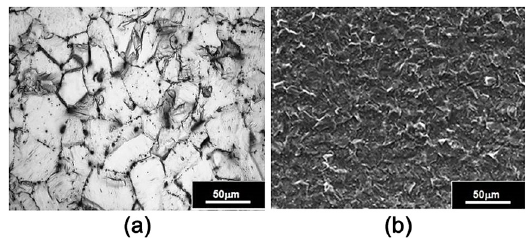
Figure 1. Micrograph of Ti cp after alkaline and thermal treatments and reaction with Kroll solution. (a) Micrograph obtained by Optical Microscopy; (b) Micrograph obtained by Scanning Electron